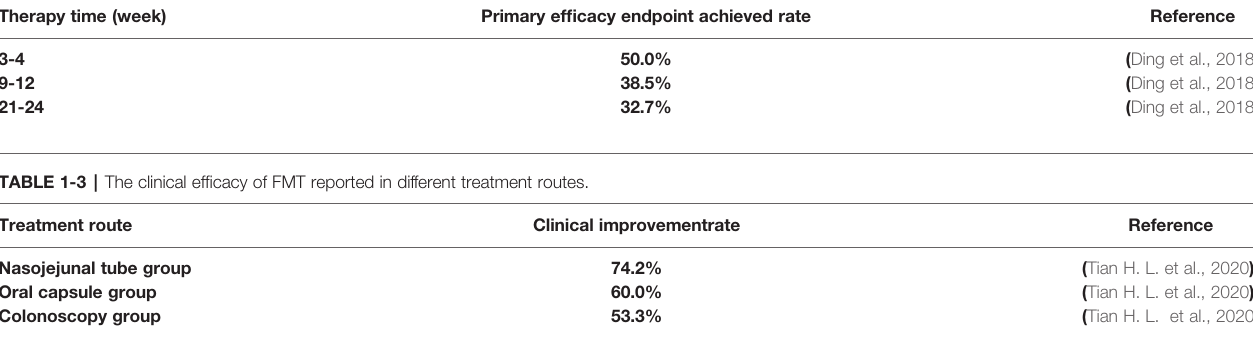
TABLE 1-2 | The clinical ef fi cacy of FMT during different therapy times.